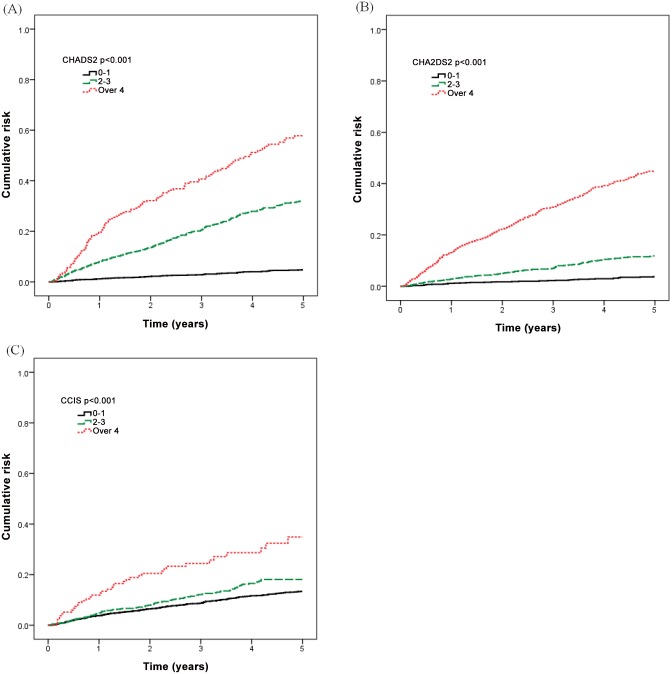
Mortality risk stratified by CHADS2, CHA2DS2, and CCI score categories.(A) CHADS2 score. (B) CHA2DS2 score. (C) CCI score.